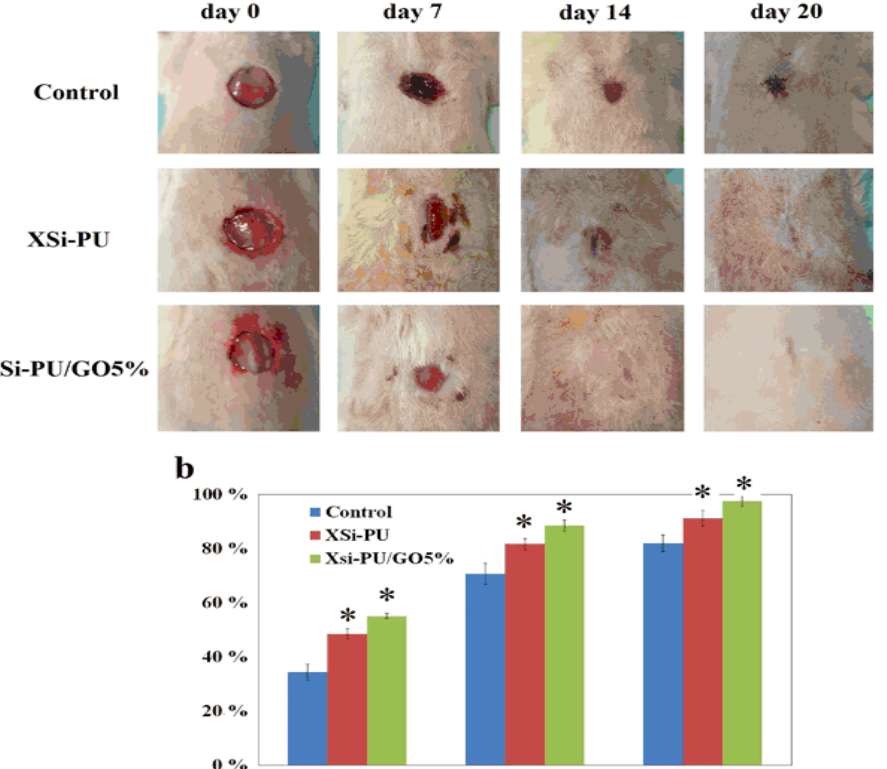
Figure 8. Pictures ( a ) and closure percentage ( b ) of wounds treated with gauze (control), polyurethane/siloxane membrane (XSi-PU), and the nanocomposite with 5 wt% GO (XSi-PU/GO5%) during the wound healing for 20 days. According to the analysis of variances, * p < 0.05, values are significantly different from the previously compared group. Taken from